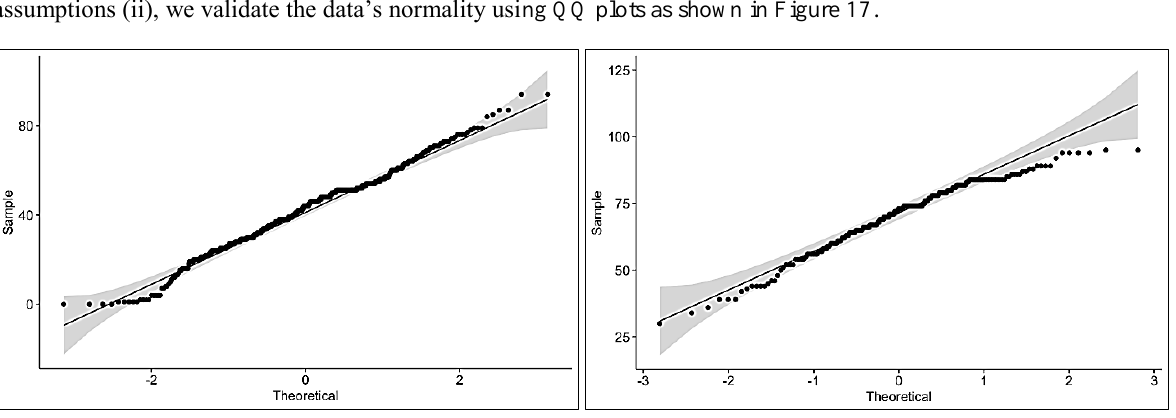
Figure 17. QQ Plots of Ages of Active/Recovered Patients (Left) and Dead Patients